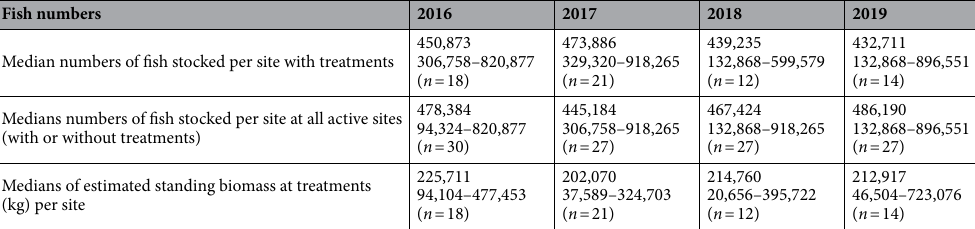
Table 2. Numbers of fish stocked at sites with sea lice treatments as well as at all active sites including estimated treated biomass at sites per year from 2016 to 2019 in NL (medians and min and max values). The number n between brackets indicate the number of sites.